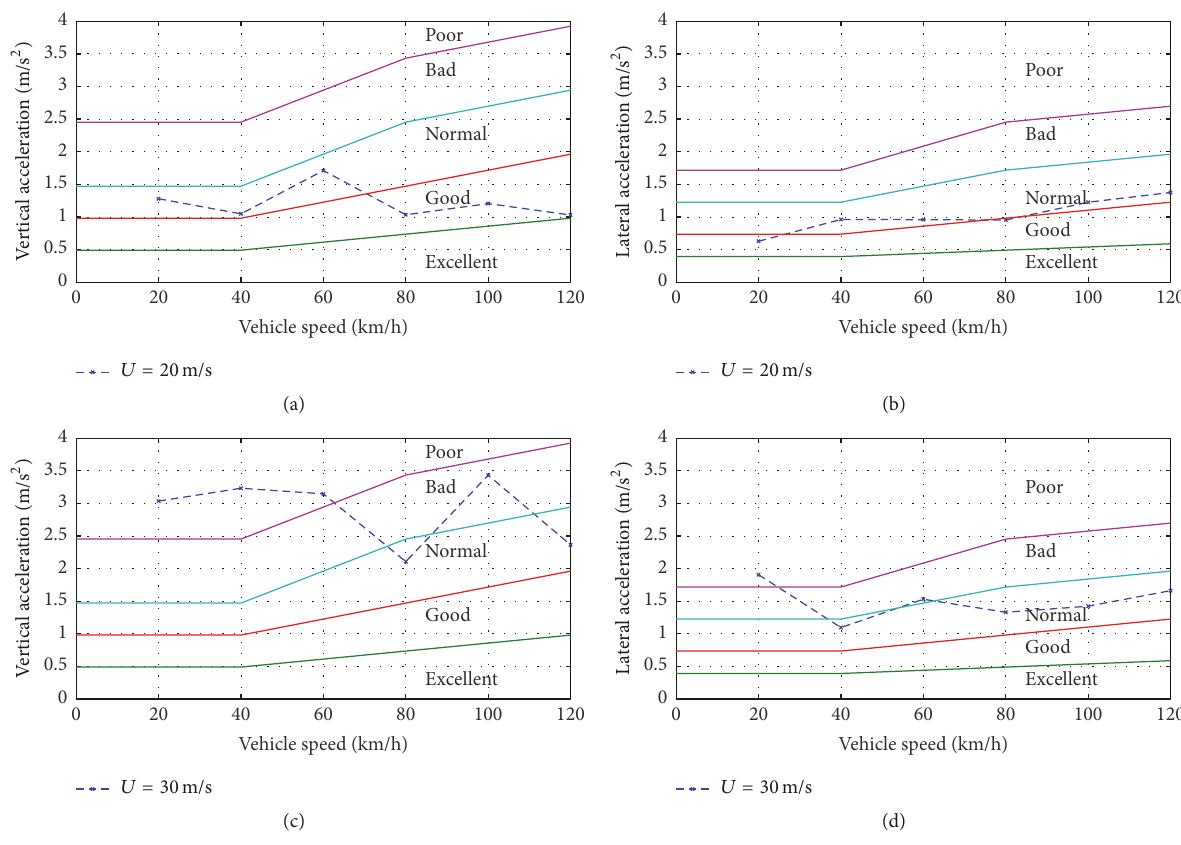
Figure 24: Evaluation of the ride quality in comparison with the design standard of UTM maglev vehicle: (a) vertical acceleration ( U = 20 m/s), (b) lateral acceleration ( U = 20 m/s), (c) vertical acceleration ( U = 30 m/s), and (d) lateral acceleration ( U =